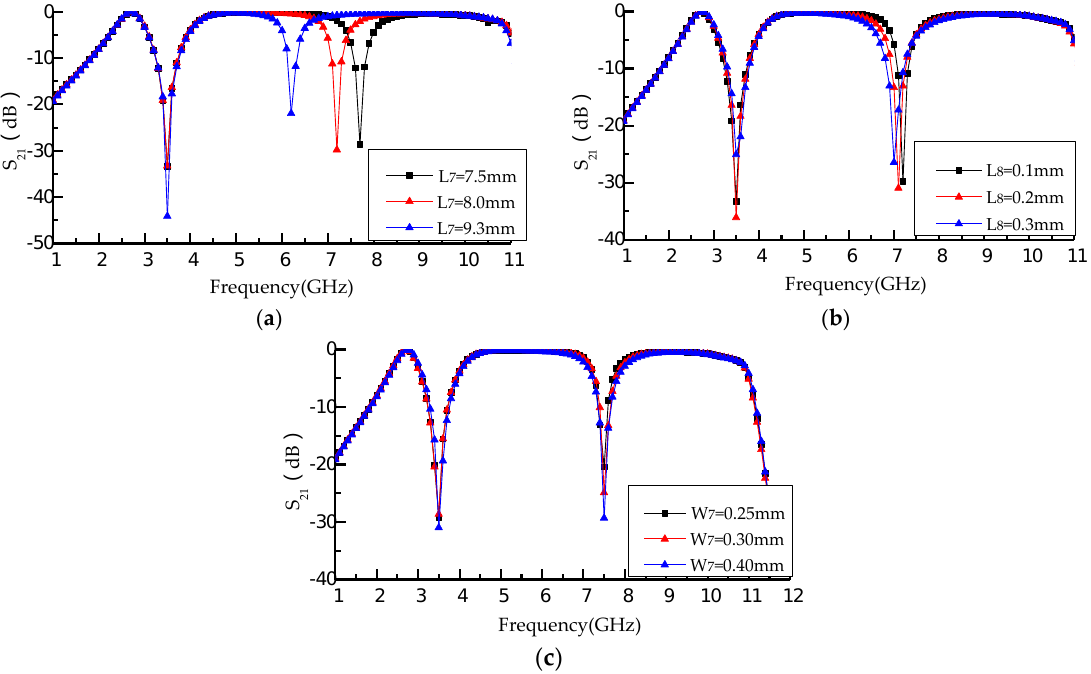
Figure 10. ( a ) Simulation results with different L 7 ( L 7 = 7.5 mm, f 02 = 7.7 GHz, L 7 = 8 mm, f 02 = 7.2 GHz, L 7 = 9.3 mm, f 02 = 6.2 GHz); ( b ) simulation results with different L 8 ( L 8 = 0.1 mm, f 02 = 7.2 GHz, L 8 = 0.2 mm, f 02 = 7.1 GHz, L 8 = 0.3 mm, f 02 = 7 GHz); ( c ) simulation results with different W 7 ( W 7 = 0.2 mm, W 7 = 0.3 mm, W 7 = 0.4 mm, f 01 = 3.5 GHz, f 02 = 7.2 GHz).